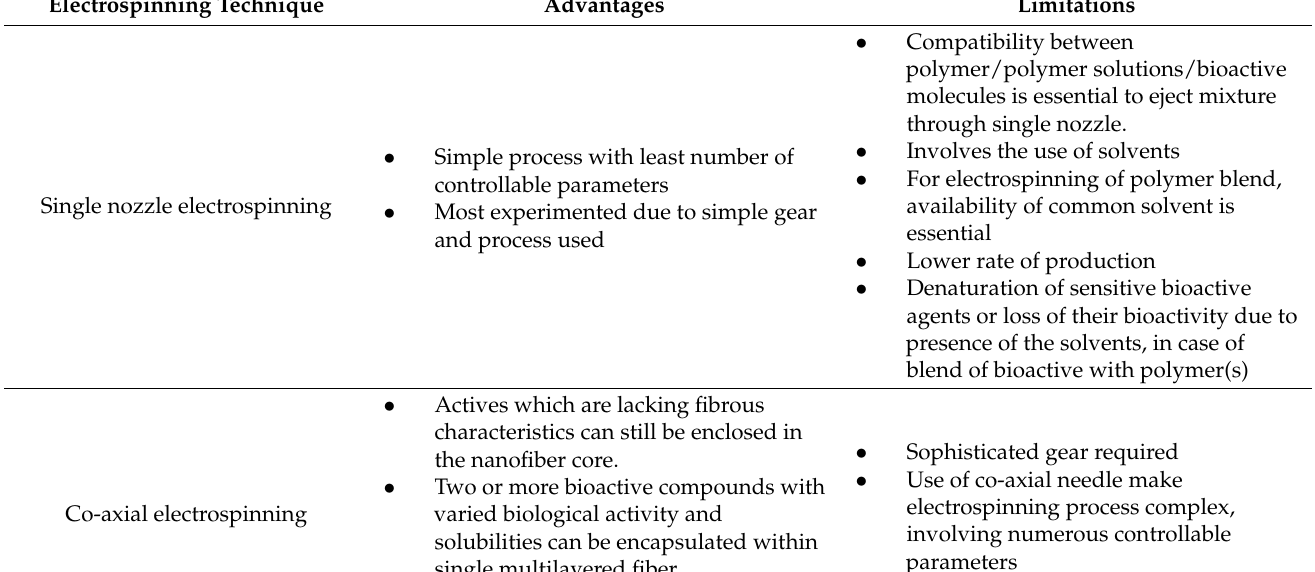
Table 4. Different electrospinning techniques to develop Nanofibers—Their Advantages and Limitations. Electrospinning